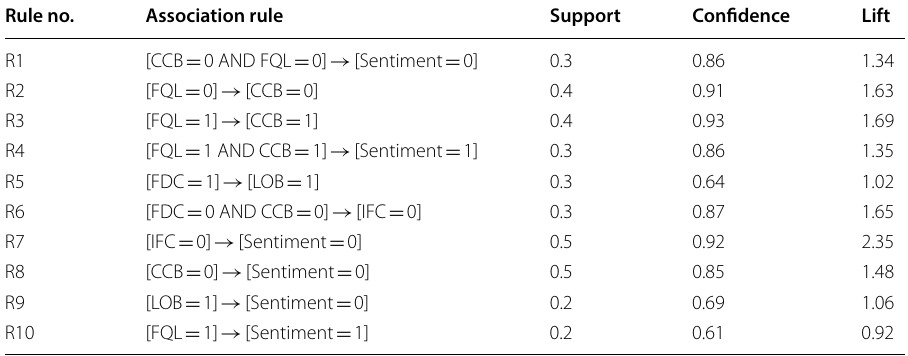
Table 4 Relevant rules illustrating the association between different categories of words Rule